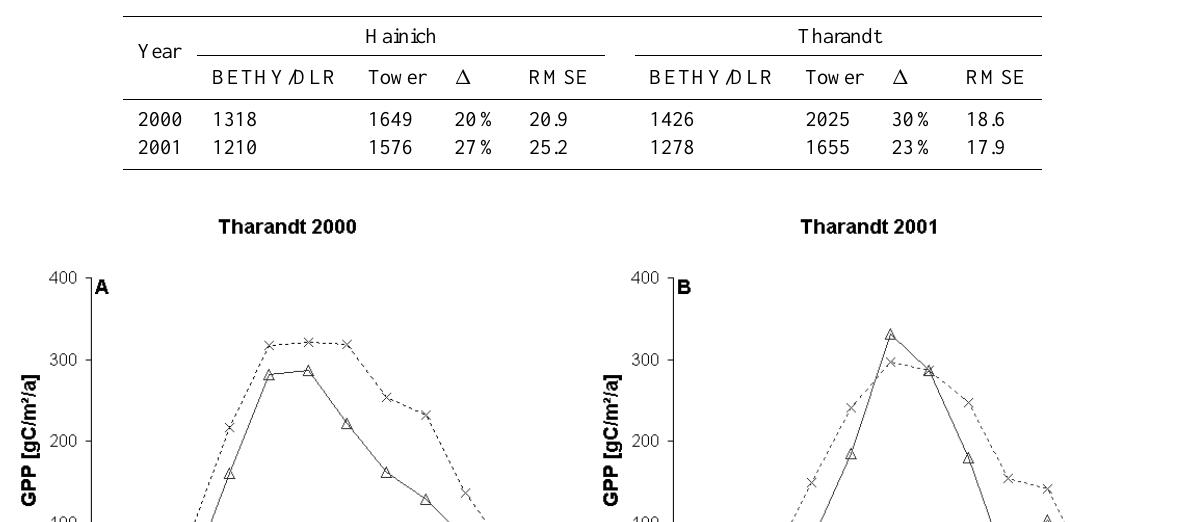
Table 3. Annual GPP sums in (gCm − 2 a − 1 ) modelled with BETHY/DLR and measured with eddy flux towers at the Hainich and Tharandt stations for 2000 and 2001. The percent difference and RMSE are provided for each comparison.